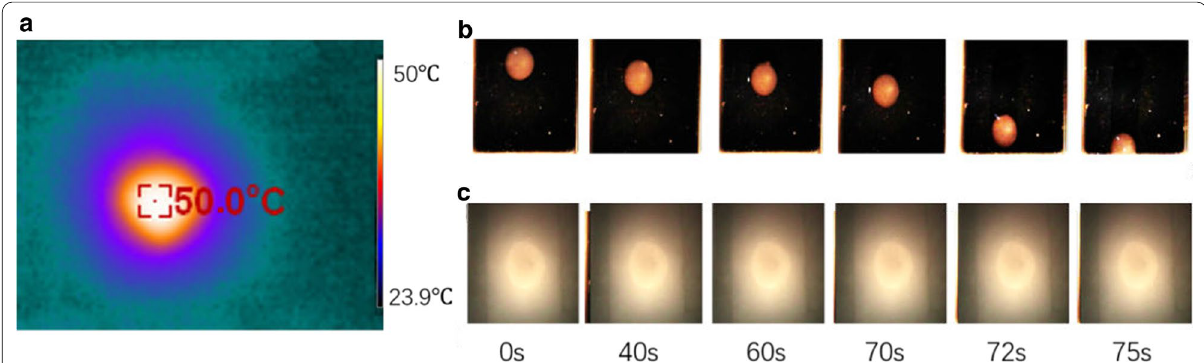
Fig. 5 a Thermal image of a metasurface absorber. b Representative snapshots of a frozen water droplet on an illuminated metasurface and